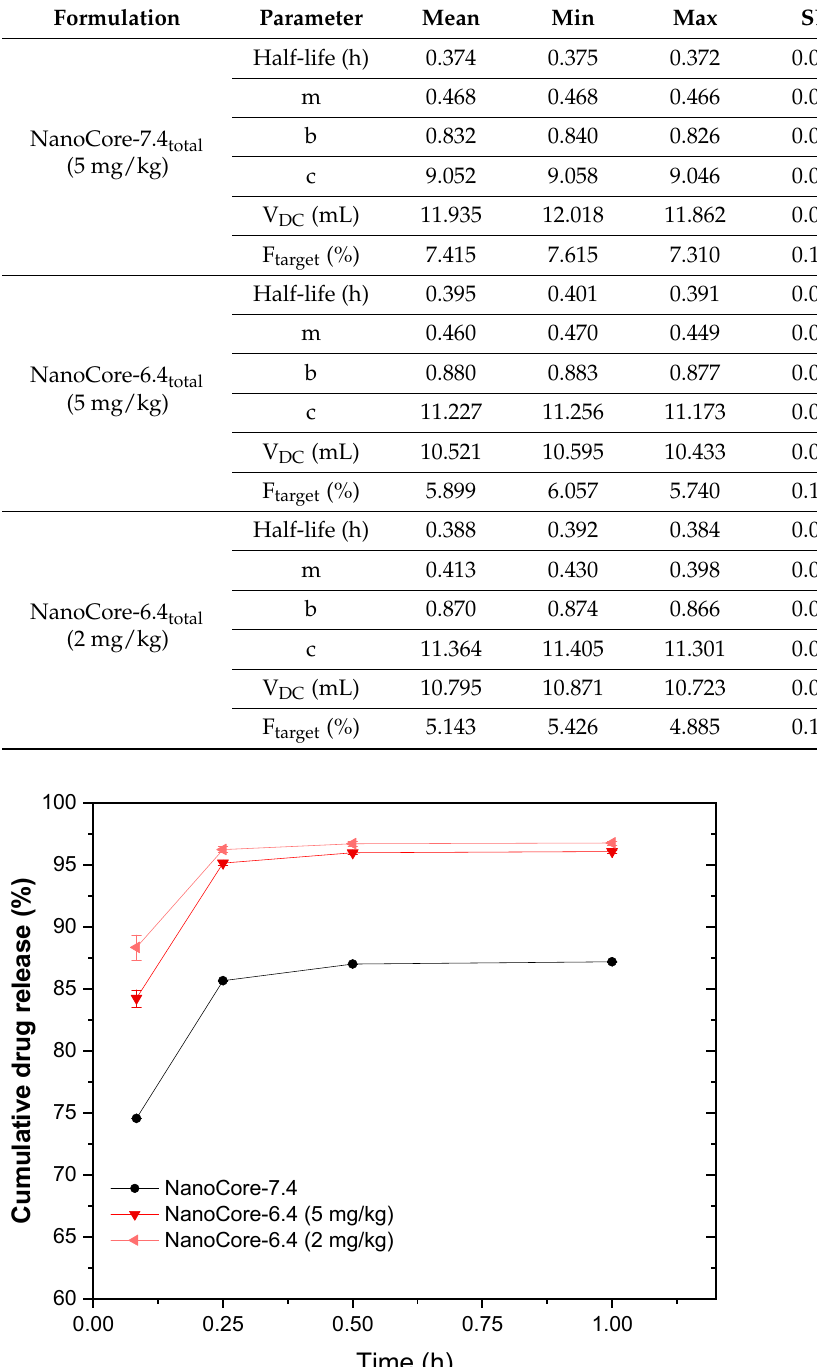
Figure 7. Estimated in vivo drug release (corresponding to the in vivo absorption) using the PBNB model. The error bars indicate the range of simulations obtained with the pre-defined parameter set. They are based on the variability of each simulation parameter used for this calculation.